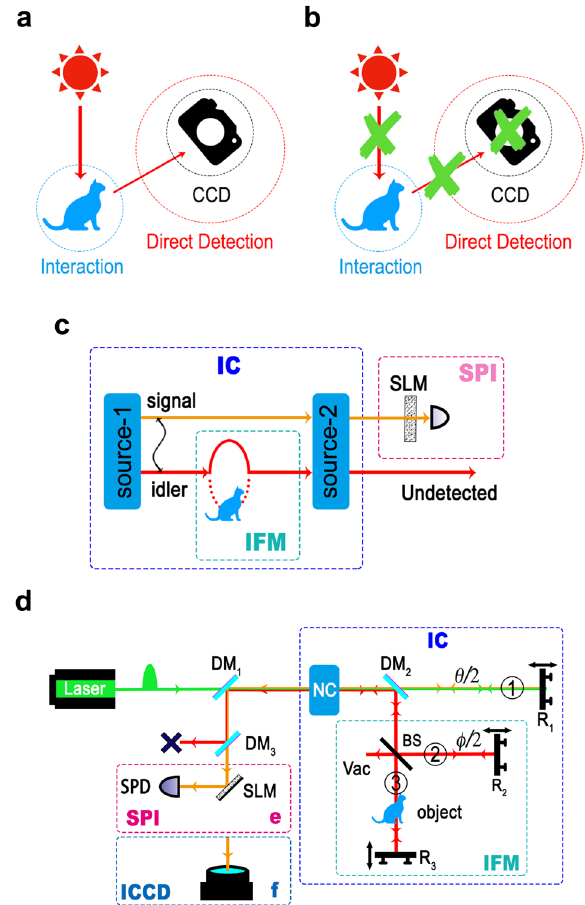
Fig. 1 Conceptual scheme and setup of interaction-free, single- pixel quantum imaging with undetected photons. a Classical imaging. Classical imaging requires a light source that emits light, which in turn interacts with the object of interest; a detector with spatial resolution directly detects light scattered from the object. b In our imaging scheme, all the above conditions are alleviated, which means imaging can be realized without direct interaction, direct detection, and a charge-coupled device (CCD) camera. c Conceptual diagram. Our imaging protocol is realized by integrating two interferometers based on the induced coherence (IC) and the interaction-free measurement (IFM) with the single-pixel imaging (SPI). d Experimental setup. A folded version of panel ( c ) realizes IC. The double-pass spontaneous parametric down- conversion processes correspond to source-1 and source-2 in panel ( c ). The IFM is realized with a single-photon Michelson interferometer. The object is placed into arm ③ of the IFM. Vac denotes the vacuum port of the IFM module. The idler photon is fi ltered out by dichroic mirror DM 3 and remains undetected throughout the entire imaging process. The circled numbers represent different arms of the interferometer. θ and ϕ represent the phase of the signal photon and the relative phase of the IFM. We also perform interaction-free quantum imaging with an intensi fi ed CCD (ICCD) camera (shown in inset f of panel d), instead of using SPI (shown in inset e of panel d). IC induced coherence, IFM interaction-free measurement, SPI single- pixel imaging, SLM spatial light modulator, DM dichroic mirror, NC nonlinear crystal, BS beam splitter, R re fl ector, SPD single-photon detector. Note: This fi gure is created by authors and does not contain any third-party materials or previously-created